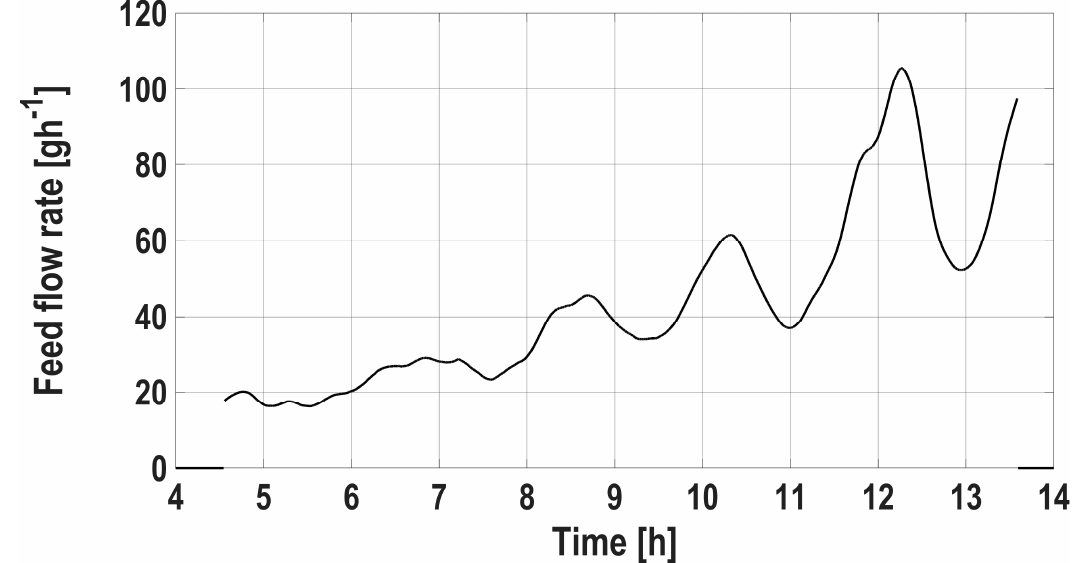
Figure 6. Feed flow rate profile obtained during a controlled fed-batch culture, controller logic (Equation